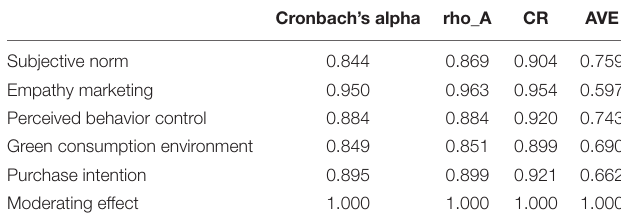
TABLE 3 | Construct reliability and validity of the